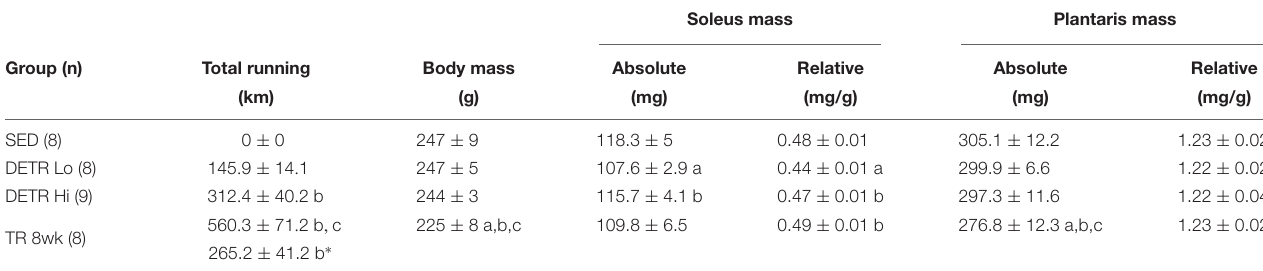
∗ Mean running distance for TR 8wk rats after 4 weeks. a – different vs. SED (p < 0.05); b – different vs. DETR Lo (p < 0.05); c – different vs. DETR Hi (p < 0.05).